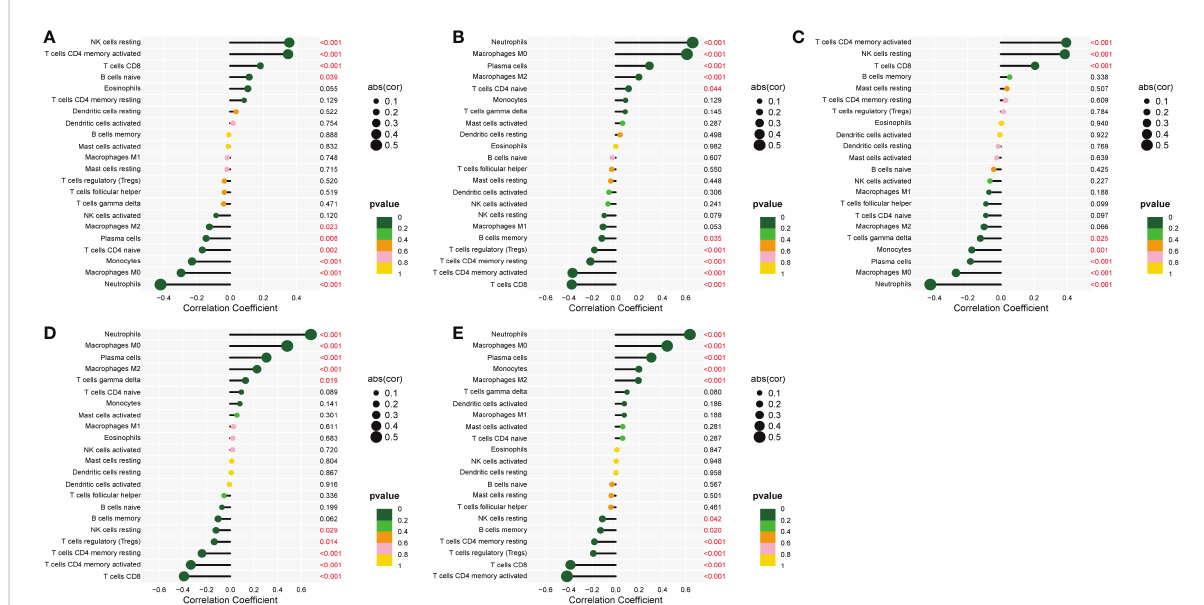
FIGURE 7 Correlation between fi ve metalloproteinase-related genes and in fi ltrating immune cells. (A) Correlation between CD160 and in fi ltrating immune cells. (B) Correlation between MMP-9 and in fi ltrating immune cells. (C) Correlation between PTGDS and in fi ltrating immune cells. (D) Correlation between SLC26A8 and in fi ltrating immune cells. (E) Correlation between TLR5 and in fi ltrating immune